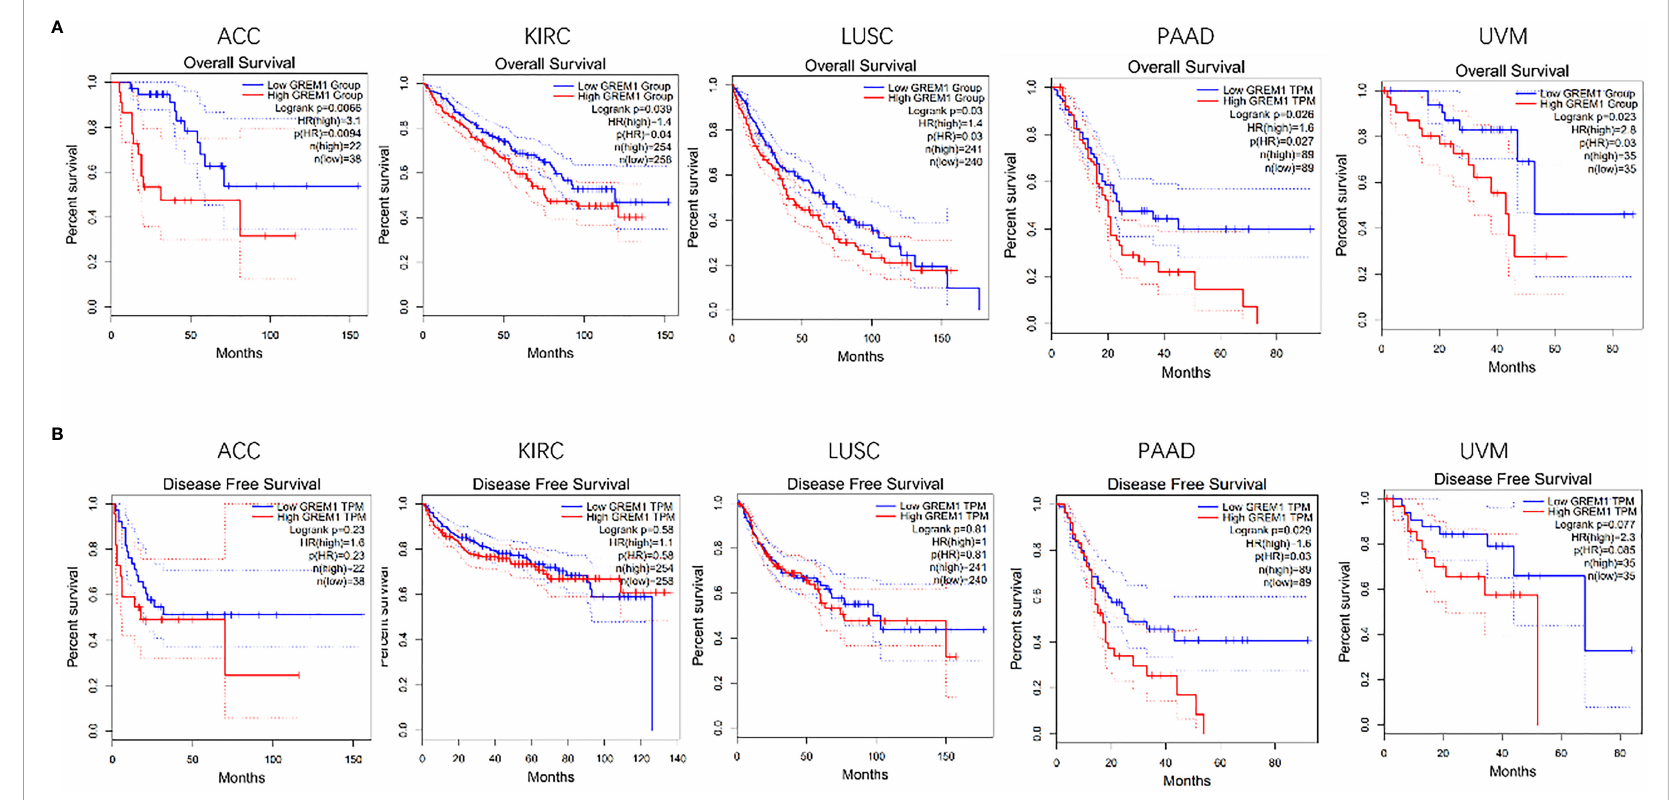
FIGURE 3 Survival analysis of GREM1 in multiple tumors was performed by Kaplan-Meier plotter. (A) OS in fi ve tumors including PDAC. (B) DFS in fi ve tumors including PDAC. OS, overall survival; PDAC, pancreatic ductal adenocarcinoma; DFS, disease-free